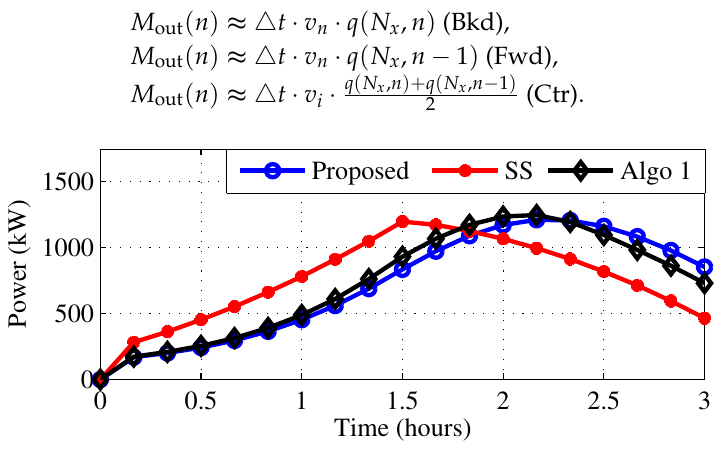
Figure 8. Calculated (Algorithm 1) and modeled values of the conveyor’s power consumption.